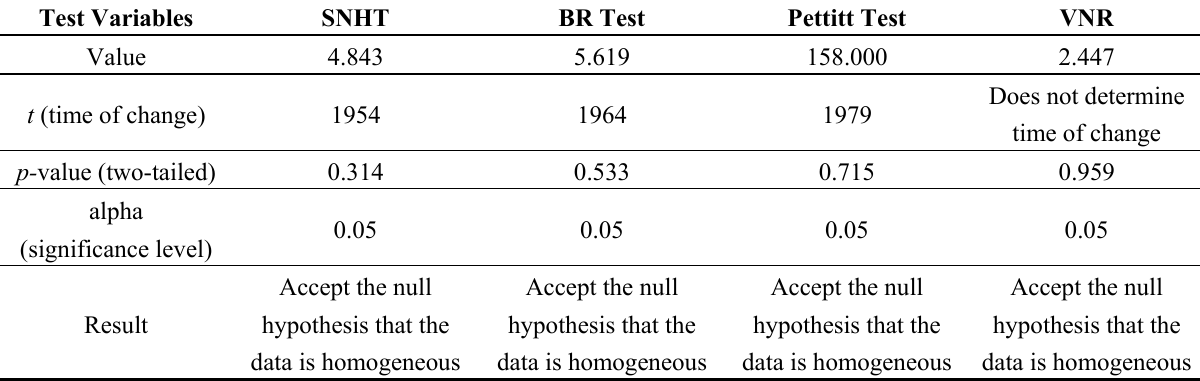
Figure 3. Annual precipitation of Huangfuchuan watershed. The dashed black line shows the five year moving average, while the straight black line shows the trend line. Table 1. Homogeneity test results for annual rainfall data of the Huangfuchuan watershed. Test Variables SNHT BR Test Pettitt